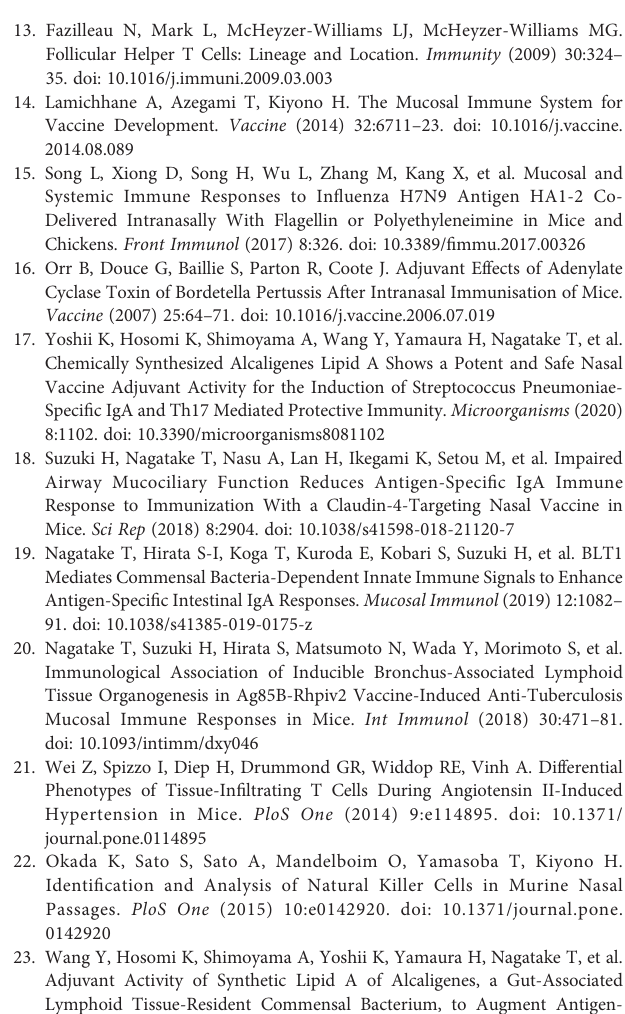
Supplementary Figure 1 | Dose-dependent activity of LPS in the induction of nasal IgA responses. Mice were nasally immunized three times with OVA alone (Mock)orwithOVAplus Alcaligenes LPS(1or10 m g)or E.coli LPS(1or10 m g).One week after the fi nal immunization, Nasal wash was collected to determine levels of OVA-speci fi c IgA by ELISA ( n = 4 per group). Supplementary Figure 2 | E. coli LPS induced lymphopenia in the blood. Mice were nasally immunized with OVA alone (Mock) or with OVA plus Alcaligenes LPS(10 m g)orE.coliLPS(10 m g). 24hoursafterimmunization, blood sampleswere collected to measure the number of lymphocytes (n = 4 per group). Data are representative of two independent experiments and analyzed by one-way ANOVA (*p < 0.05; n.s., not signi fi